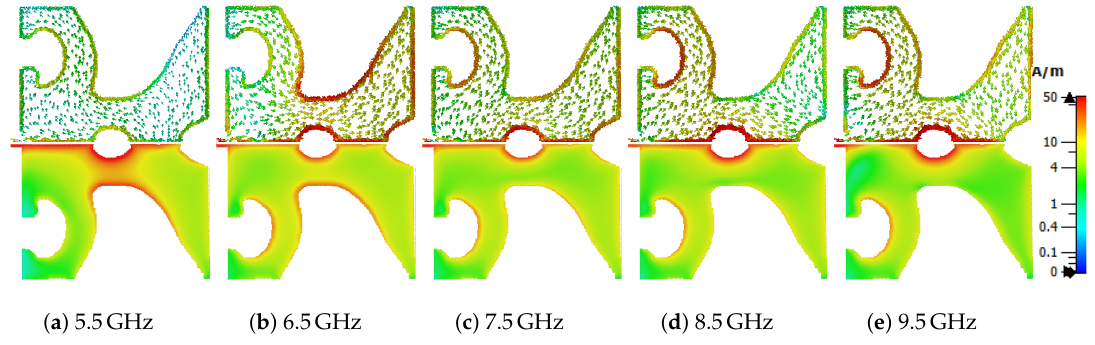
Figure 9. Surface current distribution on Antenna II. Table 3. Maximum gain and 3dB beamwidths of Antenna III (Figure10).